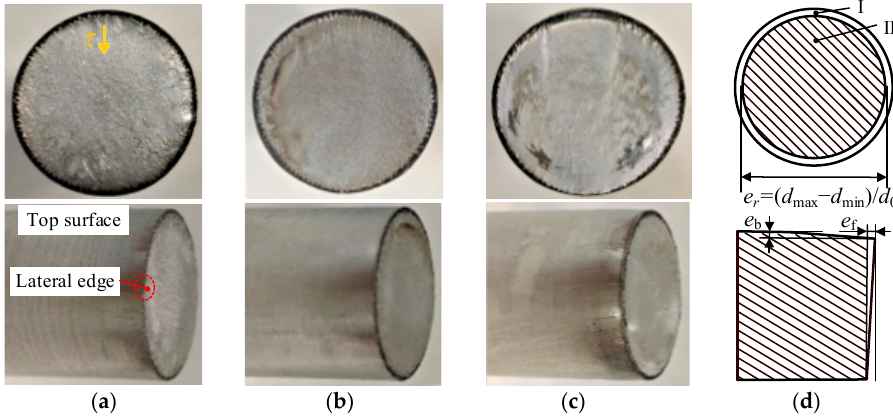
Figure 9. Macro-fractography for Test 1 with circumferential kerf. ( a ) Q235. ( b ) 40 Cr. ( c ) 304. ( d ) Evaluation indexes.